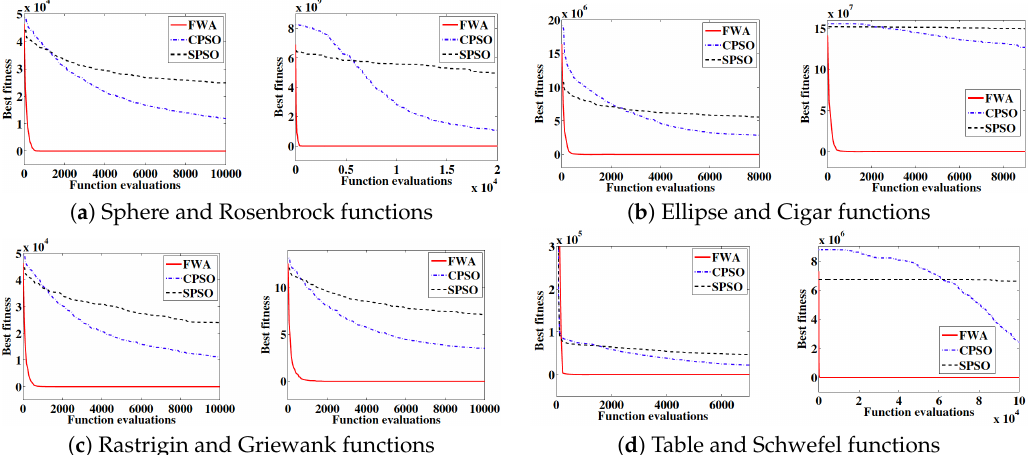
Figure 7. Convergence curves of the FA, the CPSO and the SPSO on eight benchmark functions. The function fitness is averaged over 20 independent runs. Reprinted from [35], with kind permission from Springer Science + Business Media. Copyright c (cid:13) Springer-Verlag Berlin Heidelberg